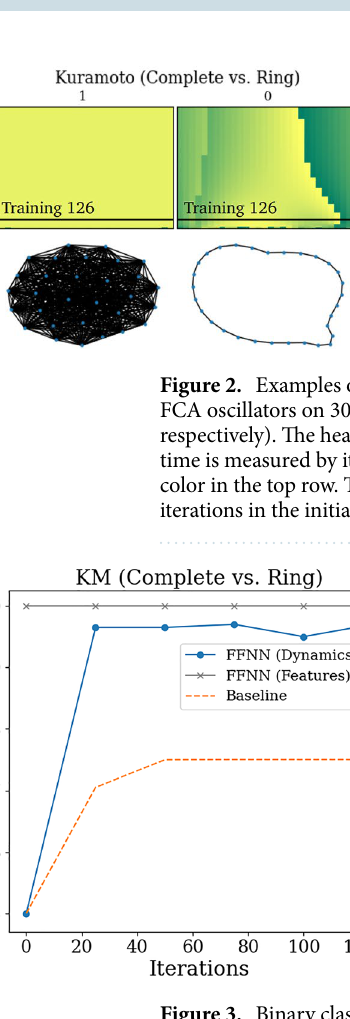
Figure 3. Binary classification accuracies of synchronizing vs. non-synchronizing dynamics when the underlying graphs in either of these two classes share the same topology. For the Kuramoto model, we compare complete graphs (synchronizing) to rings (non-synchronizing), for the GHM model we compare rings (synchronizing) vs complete graphs (non-synchronizing), and for FCA we compare trees with maximum degree 4 (synchronizing) to rings (non-synchronizing). FFNN (Features) uses FFNN as the binary classification algorithm with five basic graph features—the number of edges, min/max degree, diameter, and the number of nodes—as the input, which achieves perfect classification in all cases. FFNN (Dynamics) uses FFNN as the binary classification algorithm with a varying number of iterations of initial dynamics as input (specified as the horizontal axis), without any information about the underlying graph. The baseline predictor uses the concentration principle (see the main text for more details). Notice that FFNN (Dynamics) far surpasses the